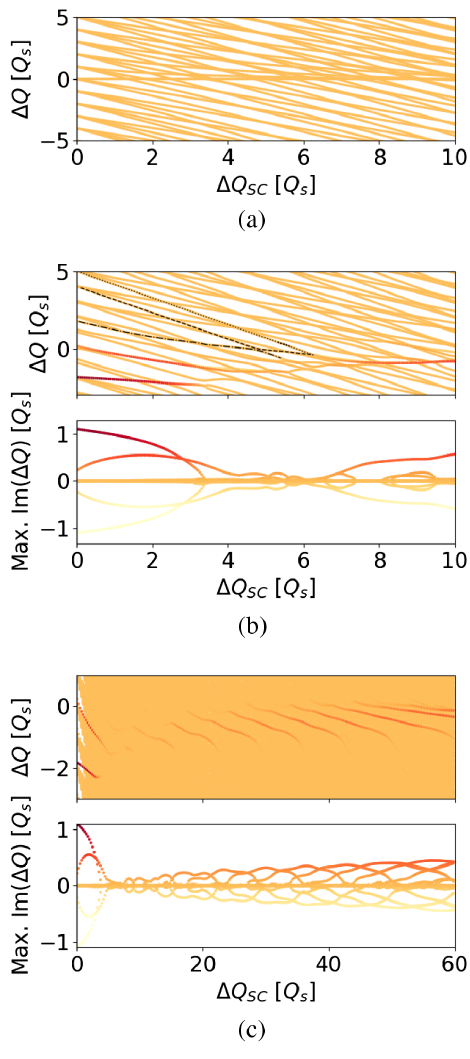
FIG. 7. Evolution of the complex tune shifts of the coherent modes as a function of the normalized space charge tune shift for a Gaussian distribution. A converged configuration featuring 100 slices and 50 rings is shown on the bottom plot (c), while a semiconverged configuration featuring only three rings is shown on the top (a) and middle plot (b). In the absence of wakefields, in the top plot (a), all tunes are purely real. In the middle plot (b), the behavior of three modes involved in the mode coupling instability are highlighted with black lines. For both plots featuring wake- fields (b) and (c), the strength of the wakefields is fixed and corresponds to a normalized intensity of